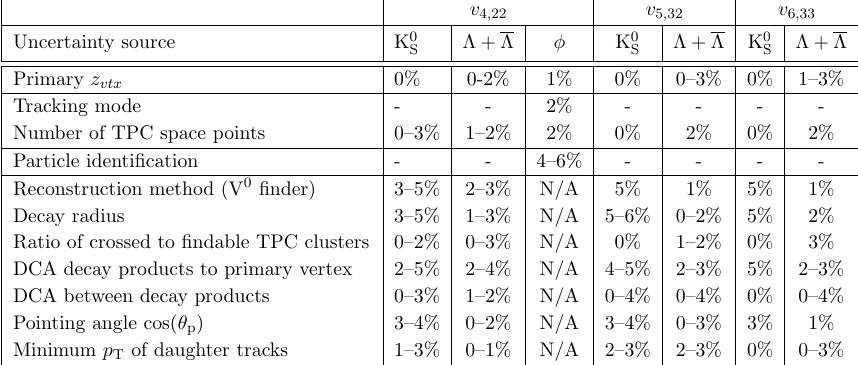
Table 2 . List of the maximum relative systematic uncertainties of each individual source for v n ; mk of K 0 , (cid:3) + (cid:3) and (cid:30) -meson. The uncertainties depend on the transverse momenta and S